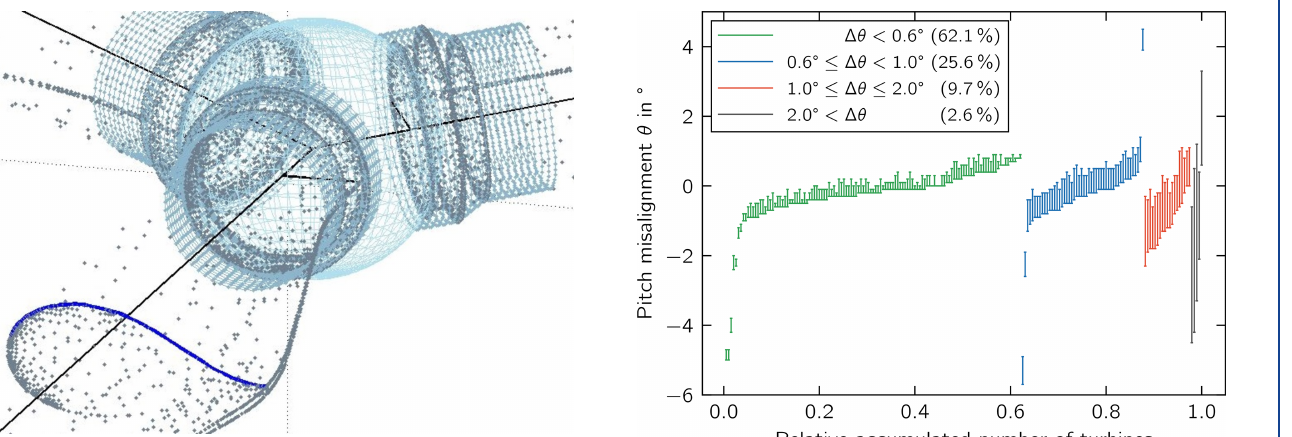
Figure 4. Measured minimum and maximum pitch angle misalign- ment across analyzed wind turbines. A positive pitch misalignment θ > 0 ◦ refers to a misalignment toward feather with respect to the target pitch